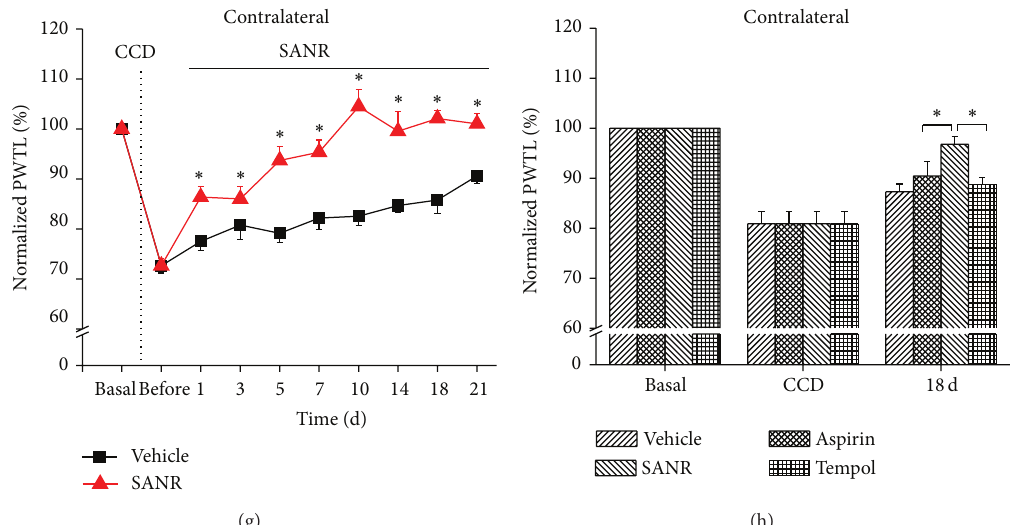
Figure 6: Repeated treatment of SANR produces antinociceptive effect on CCD-induced mechanical hypersensitivity and thermal hyperalgesia in bilateral hindpaws, which is more potent than parent nitroxide moiety Tempol and parent NSAIDs moiety aspirin. (a, c) Time course of mechanical hypersensitivity (a) and thermal hyperalgesia (c) in ipsilateral hindpaw of CCD rats before and after repeated i.p. SANR (180 𝜇 mol/kg) (red) and vehicle treatment (black). Note that ipsilateral mechanical and thermal hyperalgesia was progressively and completely reversed by SANR. (b, d) Comparison of analgesic potency in ipsilateral mechanical (b) and thermal hyperalgesia (d) produced by the same concentration of SANR, Tempol, and aspirin for 18 days. Note that SANR showed significantly stronger effect than Tempol and aspirin. (e, g) Contralateral mechanical hypersensitivity (e) and thermal hyperalgesia (g) were reduced by repeated SANR administration as well. (f, h) Comparison of the efficacy by SANR with Tempol and aspirin in inhibiting mechanical (f) and thermal hyperalgesia (h) at 18d during continuous drug administration. All data are expressed as mean ± S.E.M. ∗ 𝑃 < 0.05